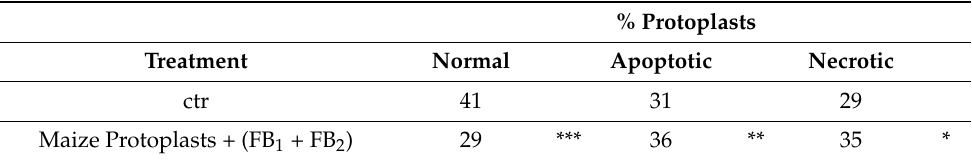
Table 1. Cell viability of protoplasts in the absence (Ctr) or presence of 25 ng of FBs (FB 1 + FB 2 ) Values represent the mean of triplicate experiments.